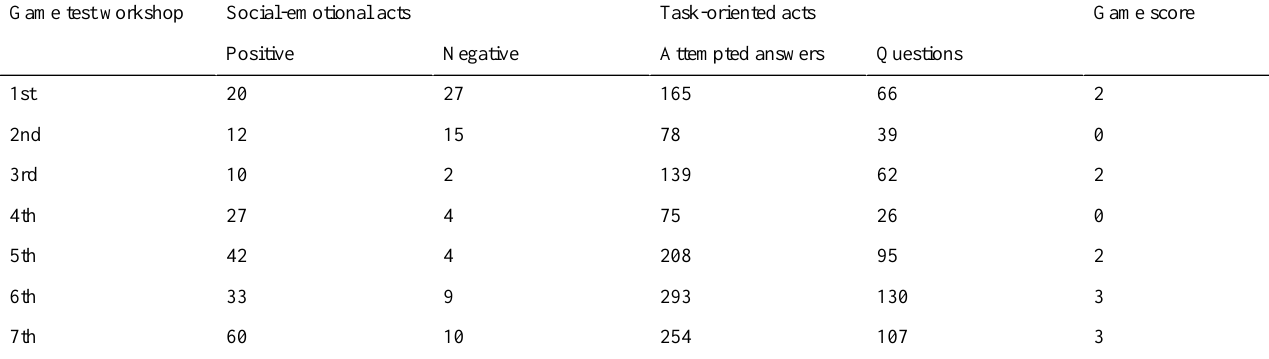
Table 2. The observed frequencies of participants’communication acts in the game-testing workshops.